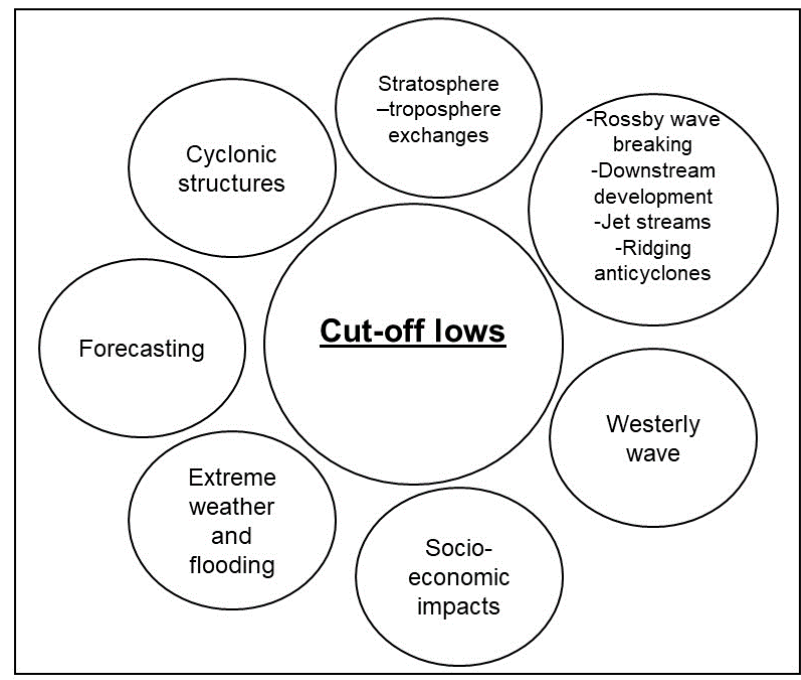
Figure 1. Conceptual framework demonstrating the literature focus on the study of COLs.